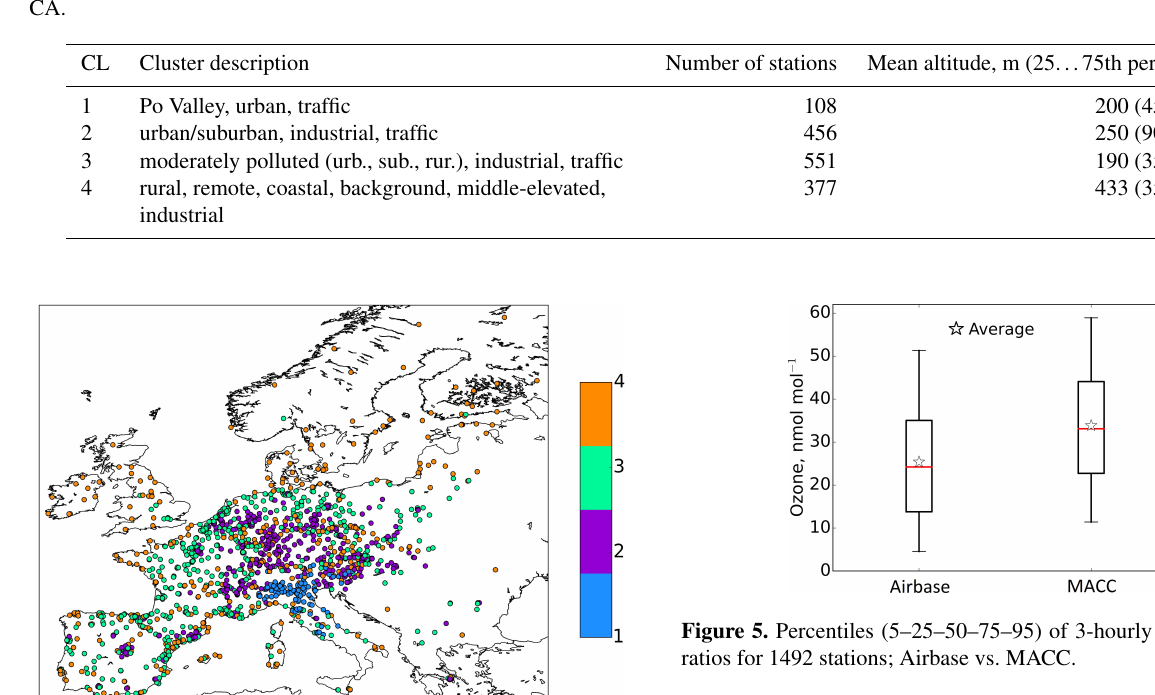
Table 3. Cluster statistics and description based on the Airbase classification, geographical location, and altitude range of clusters; second CA.